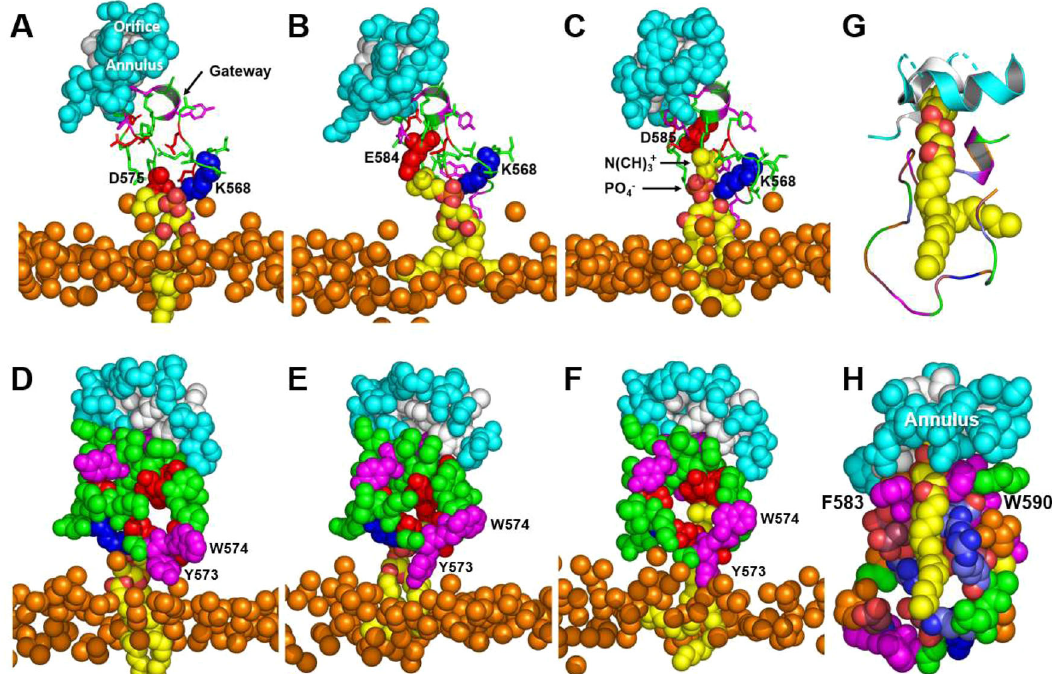
Fig. 4 | Sequential interactions with gateway residues as an extracted POPC moleculetranslocatesfromtheexternaltransmembranecavitytotheannulus ori fi ce. A – C Salt-bridge formation of acidic amino acid residues D575, E584, and D585withtheN(CH) 3 + headgroupmoietyofPOPCasthelipidmoleculemovesfrom the monolayer toward the annulus during MD simulation. Gateway, green cartoon with attached stick amino acid residues (aromatic residues, magenta); annulus, cyan space- fi lling; annulus ori fi ce, white space- fi lling; extracted POPC, yellow space- fi lling; salt bridged amino acid residues, space- fi lling; location of outer